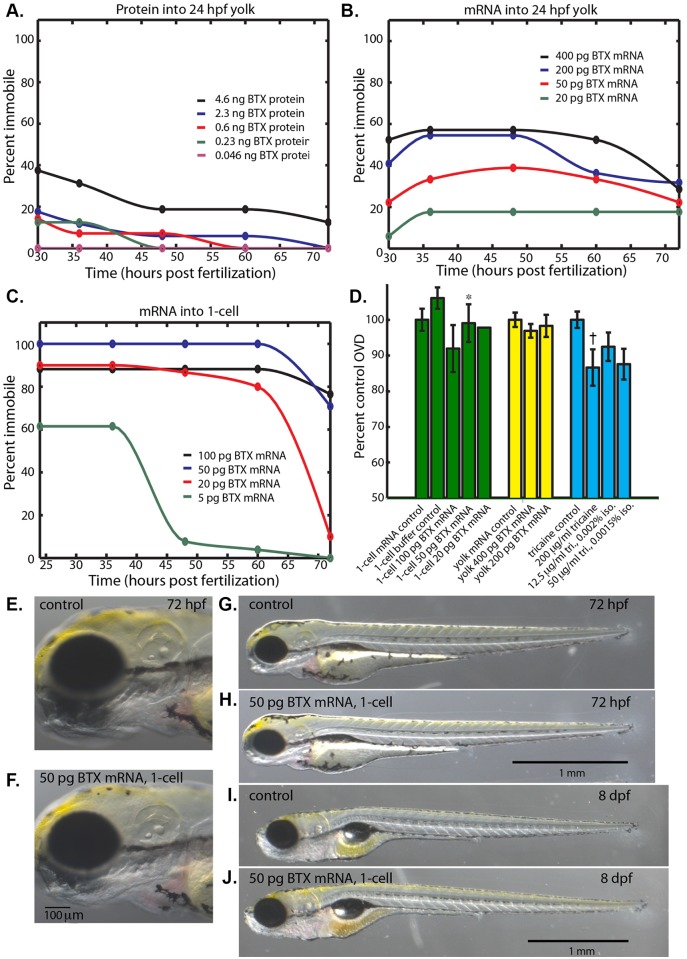
α-bungarotoxin immobilizes embryos while permitting normal development.
(A) Percent of embryos immobile after injection of α-bungarotoxin protein (0.046–4.6ng) into the yolk at 24 hpf. (B) Percent of embryos immobile after injection of α-bungarotoxin mRNA (20–400 pg) into the yolk at 24 hpf. (C) Percent of embryos immobile after injection of of α-bungarotoxin mRNA (5–100 pg) into the 1-cell zygote. (D) Percent control OVD at 72 hpf for injection of α-bungarotoxin mRNA into the 1-cell zygote (green), into the yolk (yellow), and reference anesthetic treatments that permitted long-term immobilization (blue). (*) Not significantly different from control, Mann-Whitney-Wilcoxon two tailed P-value 0.87. (†) Significantly different from control, Mann-Whitney-Wilcoxon two tailed P-value 0.0011. (E, G) Control embryo at 72 hpf that was injected with 50 pg of membrane-citrine mRNA into the 1-cell zygote. (F, H) 72 hpf embryo that was injected with 50 pg of α-bungarotoxin mRNA into the 1-cell zygote. (I) Control larva at 8 days post fertilization (dpf) injected with 50 pg of membrane-citrine mRNA into the 1-cell zygote. (J) 8 dpf larva that was injected with 50 pg of α-bungarotoxin mRNA into the 1-cell zygote.